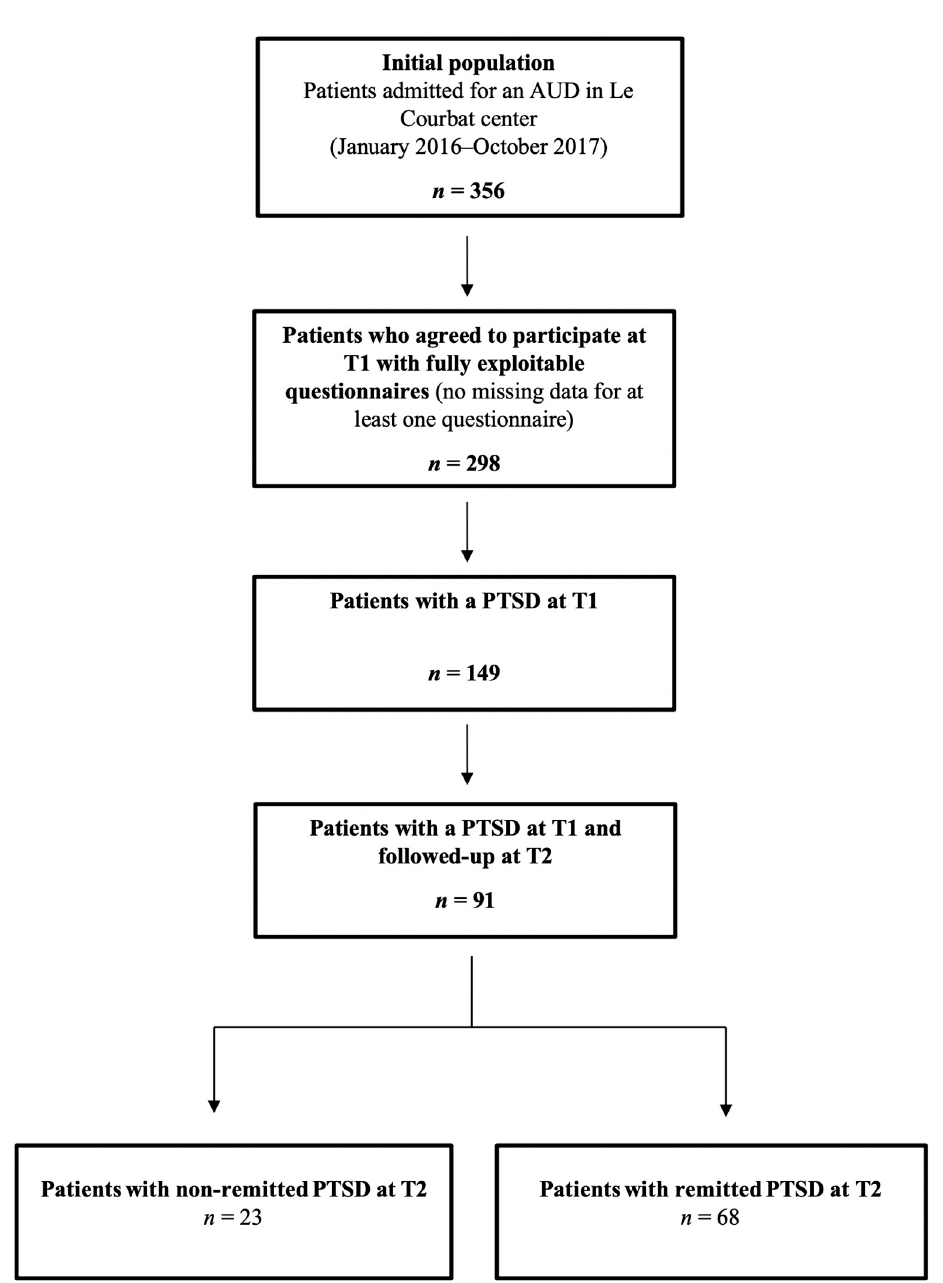
Figure 1. Study flow chart. Note: AUD, Alcohol Use Disorder; AUDIT, Alcohol Use Disorders Identification Test; PTSD, Post-Traumatic Stress Disorder. T1, Assessment one week after admission (baseline assessment); T2, Assessment eight weeks after initial assessment (one week before discharge).